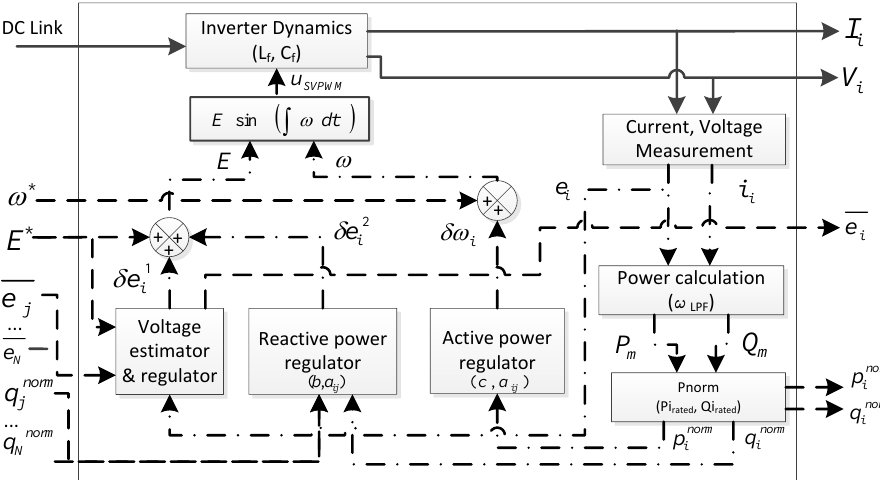
Figure 7. IDG CPES module (cooperative free-droop